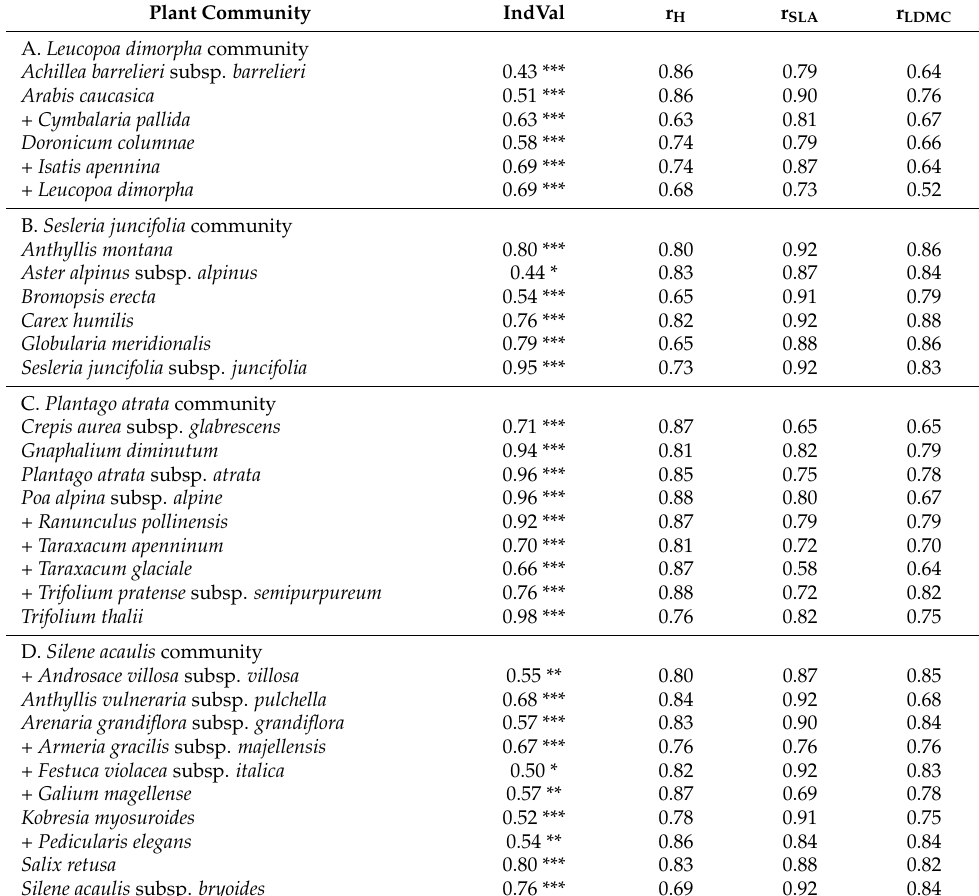
Table 2. List of community indicator species for each plant community derived from ISA analysis. For each taxon, we report the indicator value (IndVal) and the species-level redundancy value for each trait (r H : plant height; r SLA : specific leaf area; r LDMC : leaf dry matter content). Statistical significance of indicator values is also reported (n.s. p > 0.05; * p < 0.05; ** p < 0.01; *** p <